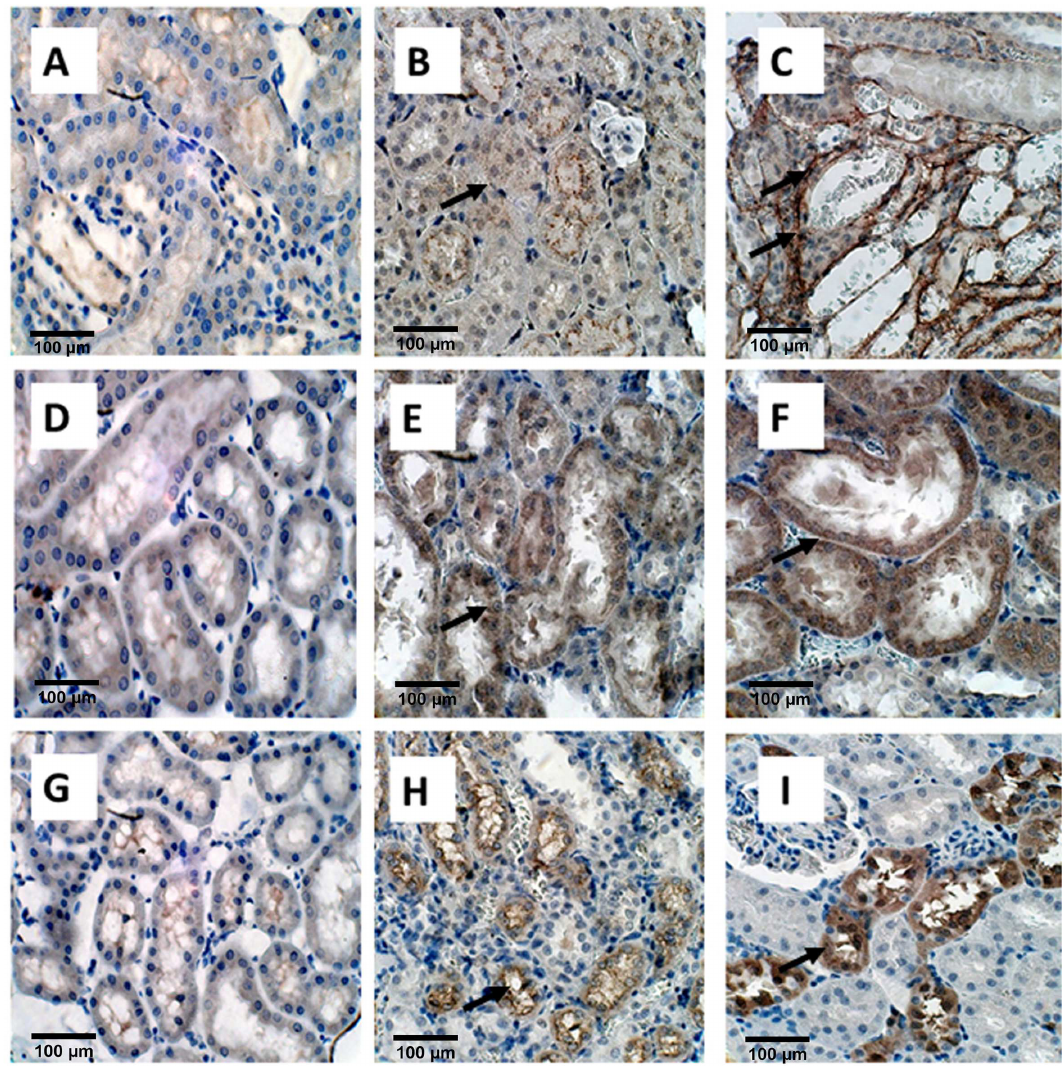
Fig 5. Immuno-histological staining of EG treated rat kidneys. Collagen, A) Control B) Light staining nonspecific staining on Day 14 shown by black arrow. C) Stainingof the tubular basementmembraneand interstitium on Day 28 shown by 2 black arrows. Magnification X40. Fibronectin, D) Control, E) strong stainingof tubular epithelialcells on Day 14 (black arrow) and F) day 28 shown by black arrow. THP, G) Control H) Tubular epithelial cells stainedpositive on both Day 14 (black arrow) and I) Day 28, but number of positive cells appearedless on day 28 then on Day 14. Magnification X40, Scale bar 100 μ m.